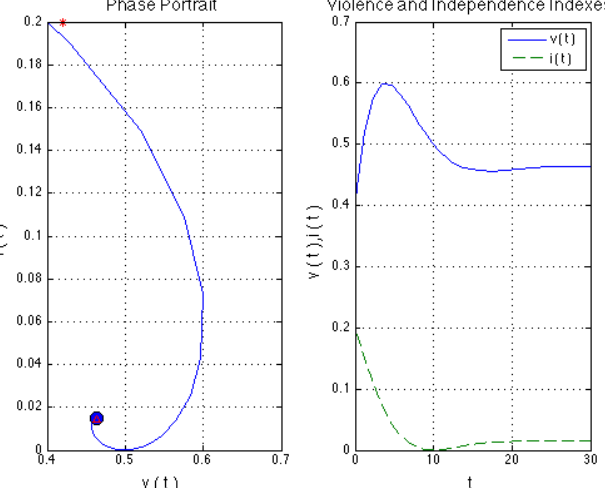
Figure 2. Violent man without alcohol consumption and submissive woman. α 1 = 0.7, α 2 = 0.6, β 1 = 0.6, β 2 = 0.5, γ = 0.5, δ 1 = 0.2, δ 2 = 0.25, ρ 1 = 0.5, ρ 2 = 0.5, µ = − 0.2, ( v ( 0 ) , i ( 0 )) = ( 0.4,0.2 )